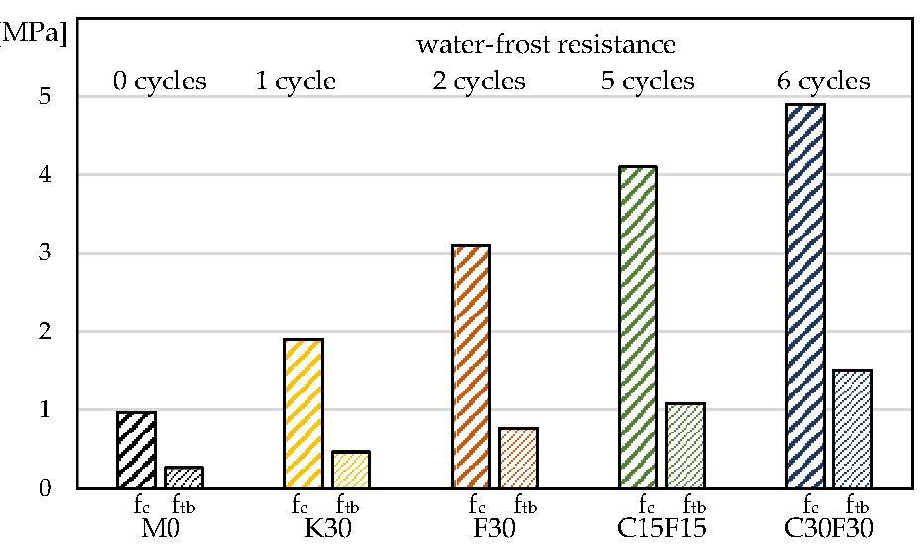
Figure 6. The compressive strength f c , three-point bending tensile strength f tb and water – frost resistance of the tested lime mortars.